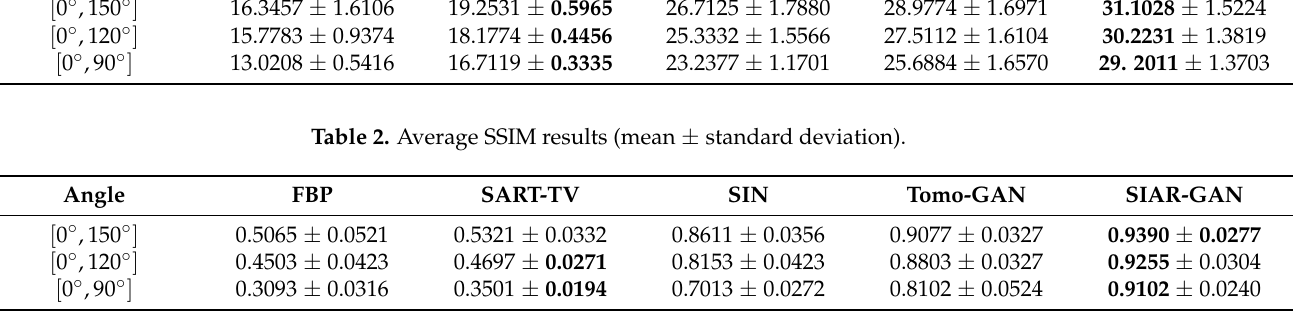
Table 1. Average PSNR results (mean  standard deviation).